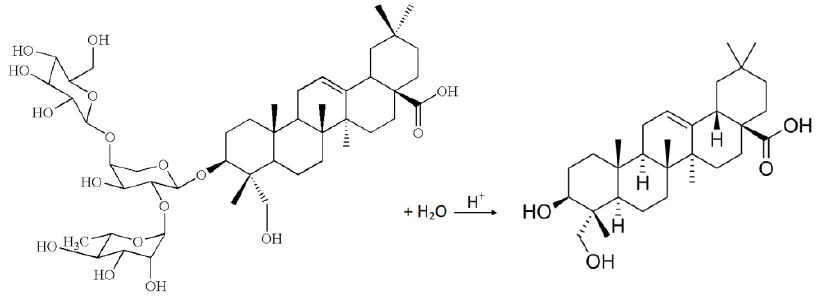
Figure 7. Sapogenin formation during an acid hydrolysis (hederagenin as example).